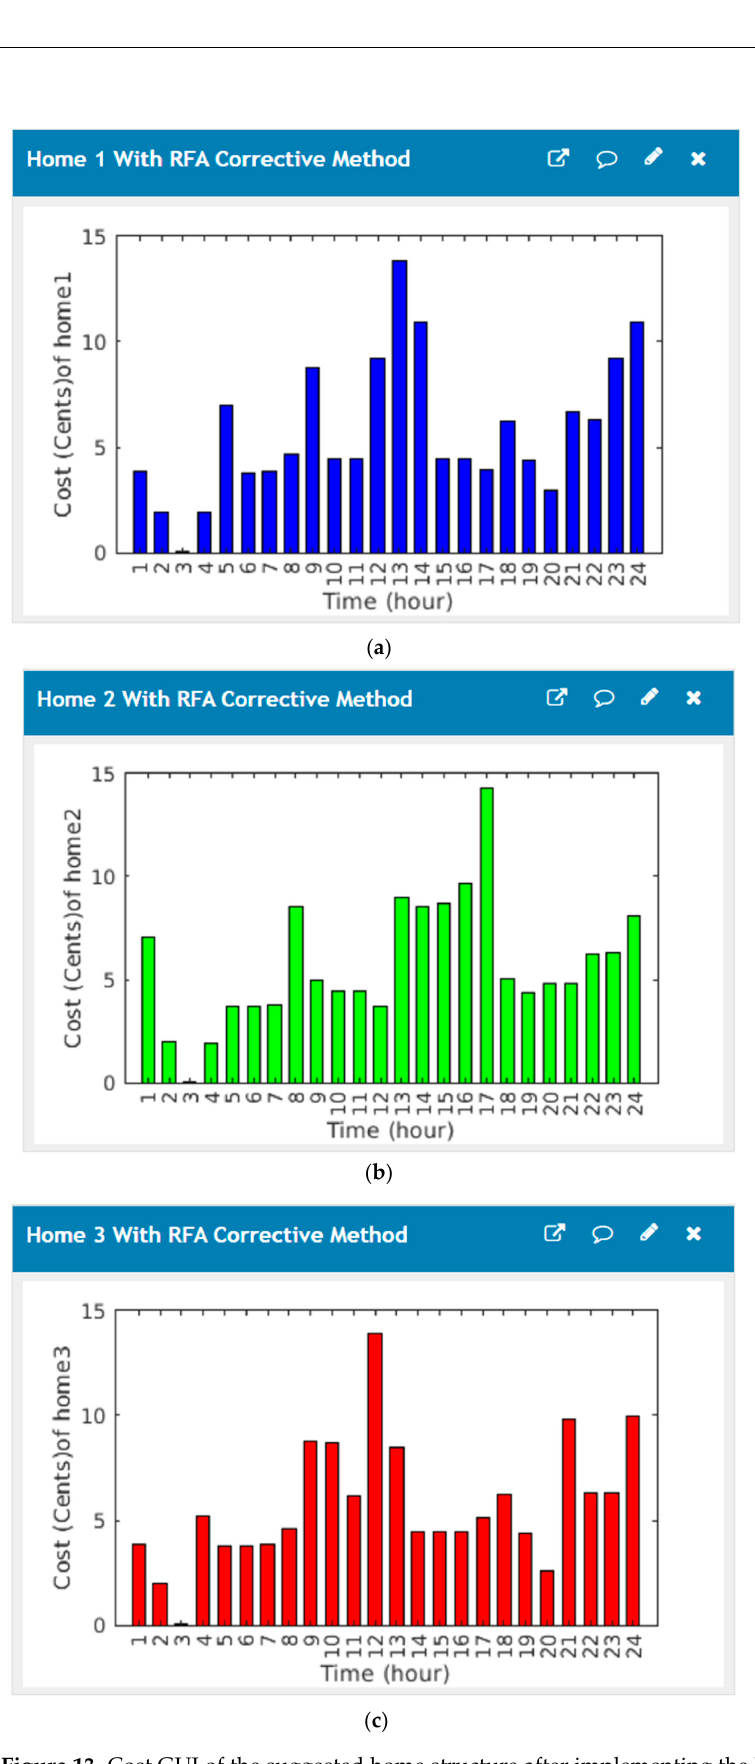
Figure 13. Cost GUI of the suggested home structure after implementing the RFA algorithm: ( a ) cost profiles of first house; ( b ) cost profiles of second house; ( c ) cost profiles of third house.